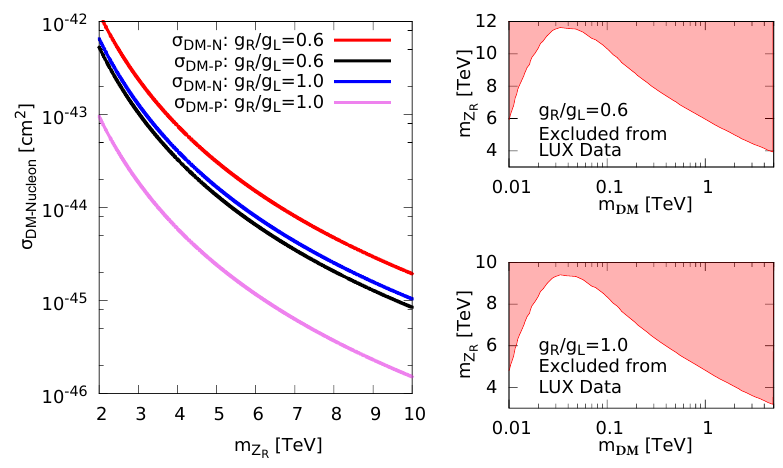
Figure 5 . (cid:31) 0 -proton and (cid:31) 0 -neutron scattering cross-sections are shown as a function of m Z sidering two di(cid:11)erent values of g R =g L = 0.6 and 1.0 in the left panel. The top right panel depicts the colored region in m DM { m Z plane which satis(cid:12)es the LUX [34] upper bound on DM-nucleon scat- R tering cross-section for g R =g L = 0.6. We show the same for g R =g L = 1.0 in the bottom right